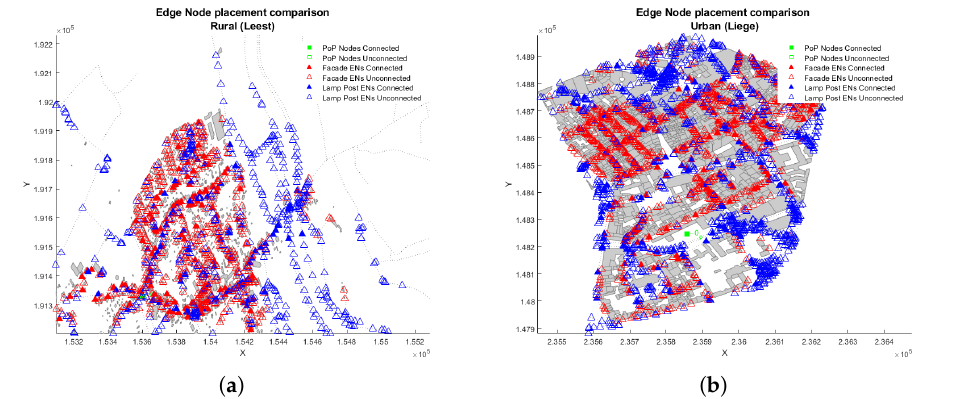
Figure 3. Edge node placement comparison. ( a ) Leest-Rural. ( b )